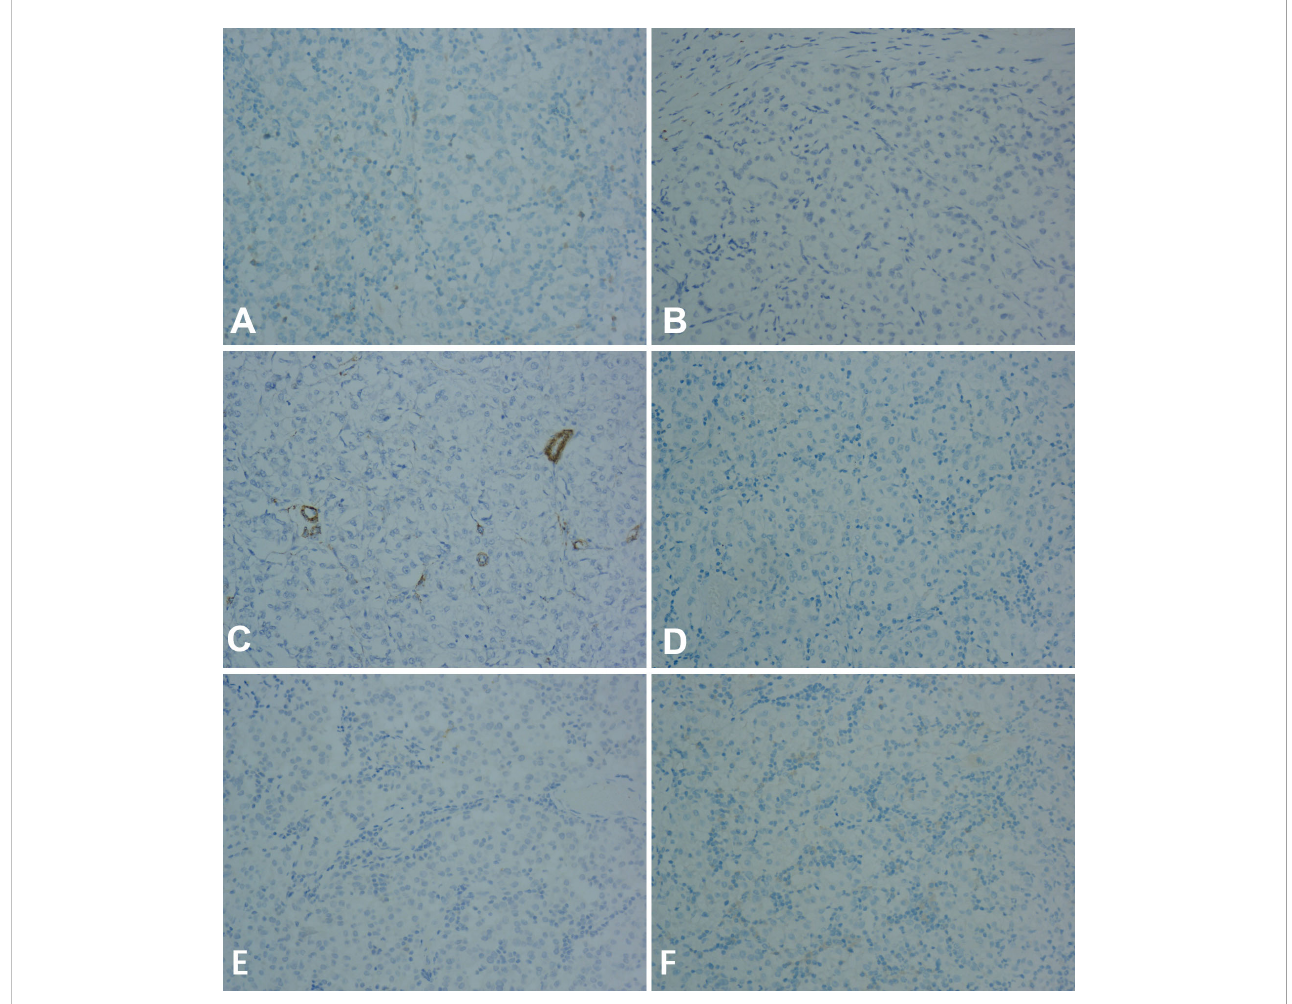
FIGURE 4 The tumor was negative for Melan-A, desmin, smooth muscle actin (SMA), S-100, CD117, and CK at 20x magni fi cation using microscope. (A) Melan-A. (B) desmin. (C) smooth muscle actin (SMA). (D) S-100. (E) CK. (F)